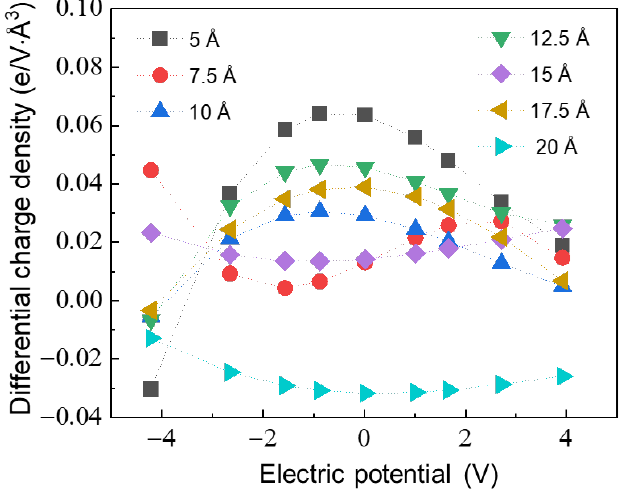
Figure 8. Differential electrolyte charge density profile as a function of electric potential.